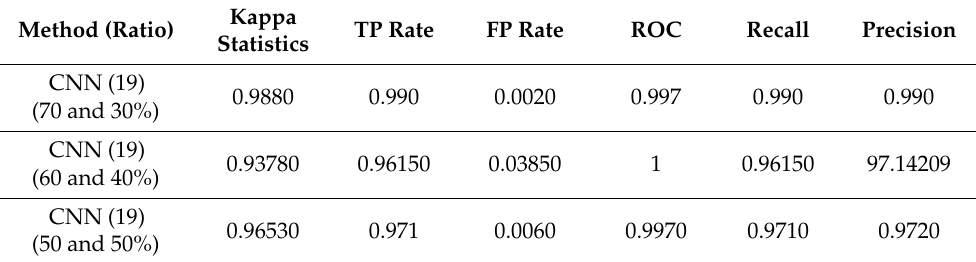
Figure 11. Overall accuracy of CNN with respect to training and testing ratios.